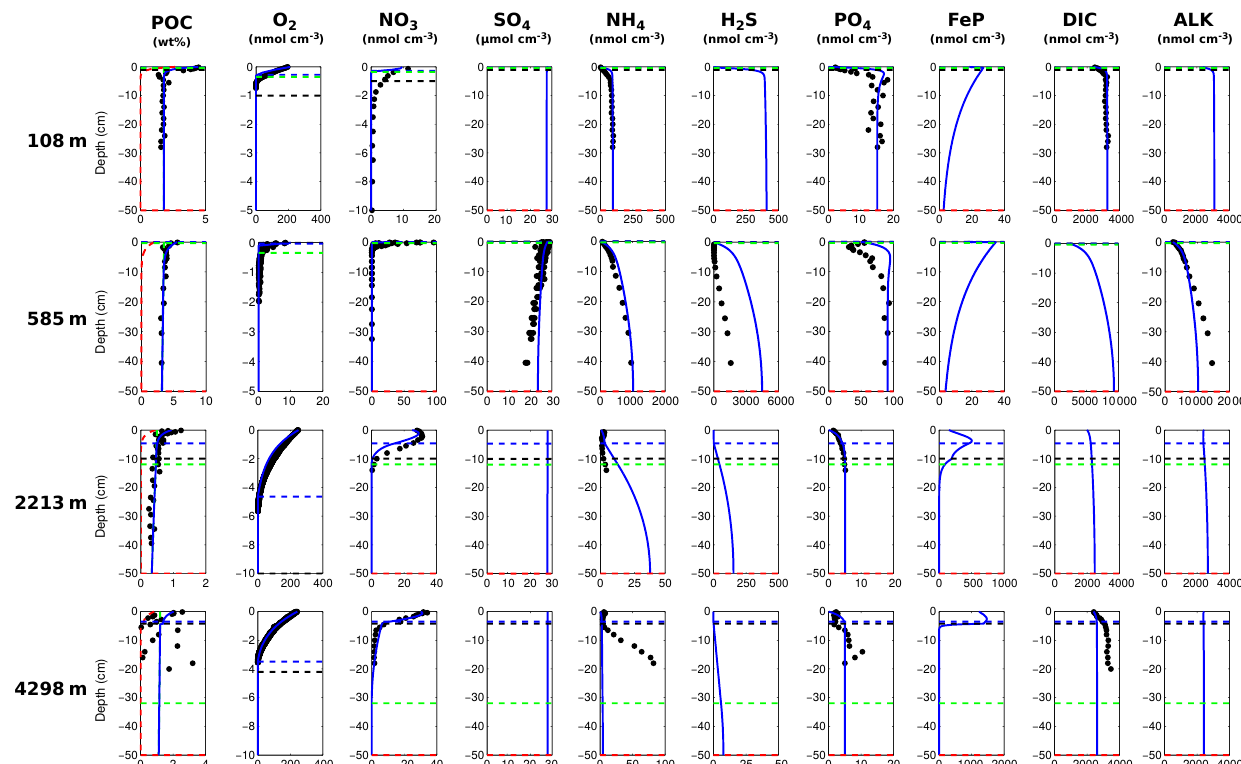
Figure 7. Modelled (curves) and measured (filled dots) solid-phase and dissolved pore water profiles for four different sediment cores. Note that different scales are used for different stations. The blue POC curve represents the sum of the refractory (green) and labile (red) POC fraction. The horizontal dashed lines in each panel indicate the bioturbation depth (black) and the penetration depths of oxygen (blue), nitrate (green) and sulfate (red) as calculated by